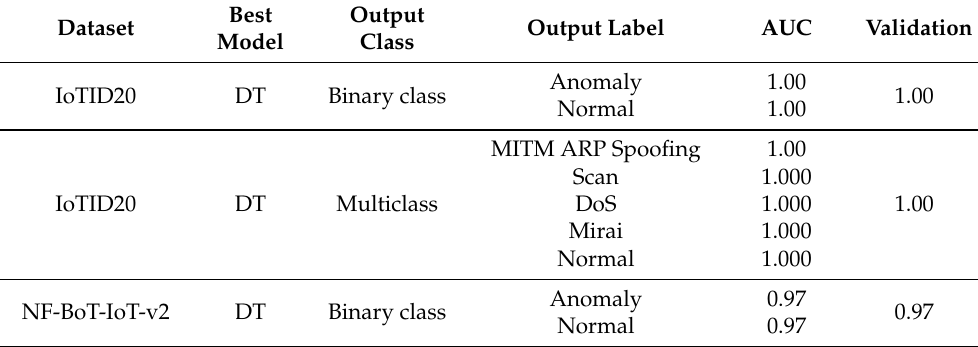
Table 4. Classification model evaluation on the datasets: IoTID20, NF-BoT-IoT-v2 &